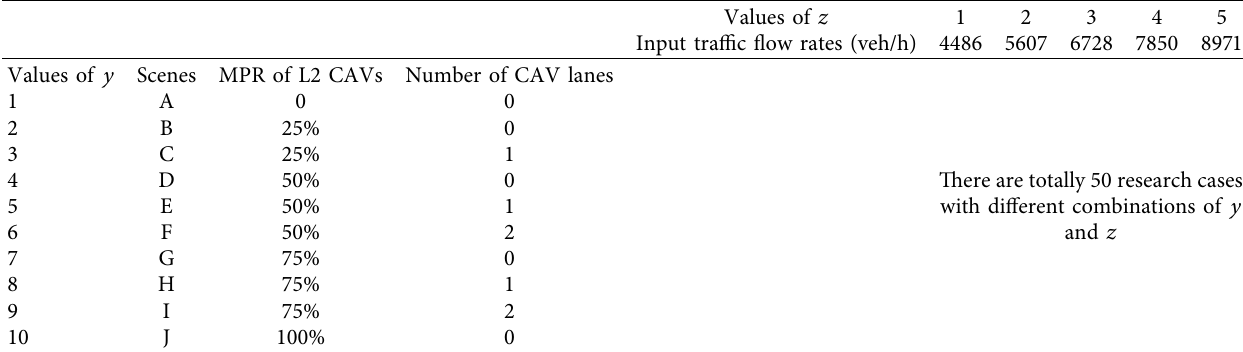
Table 1: Research cases with diferent combinations of y and z